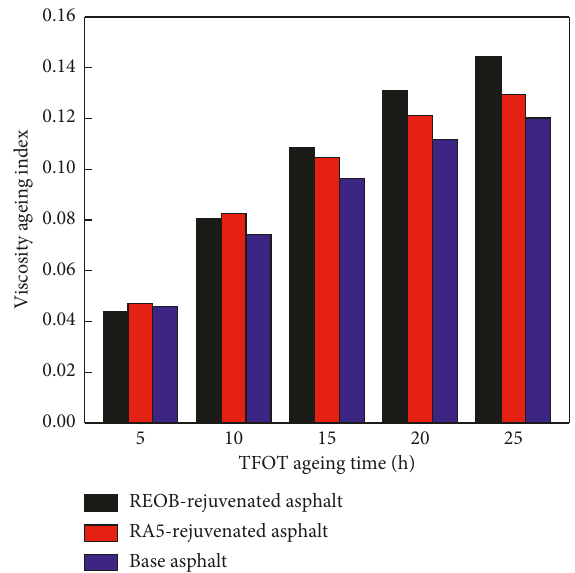
Figure 4: Relations between viscosity ageing index and TFOT ageing time for the three kinds of